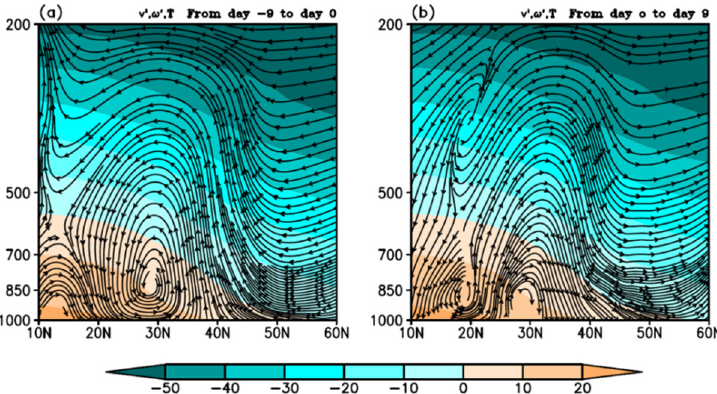
Figure 9. The 10–40-day filtered vertical meridional circulation averaged from 170 ◦ E to 150 ◦ W. The shading represents the mean temperature (time scale > 40 days) (unit: ◦ C), and the streamline represents the intraseasonal meridional wind (unit: m/s) and vertical velocity (10 − 2 Pa/s). ( a ) shows the average from day − 9 to day 0, ( b ) shows the average from day 0 to day